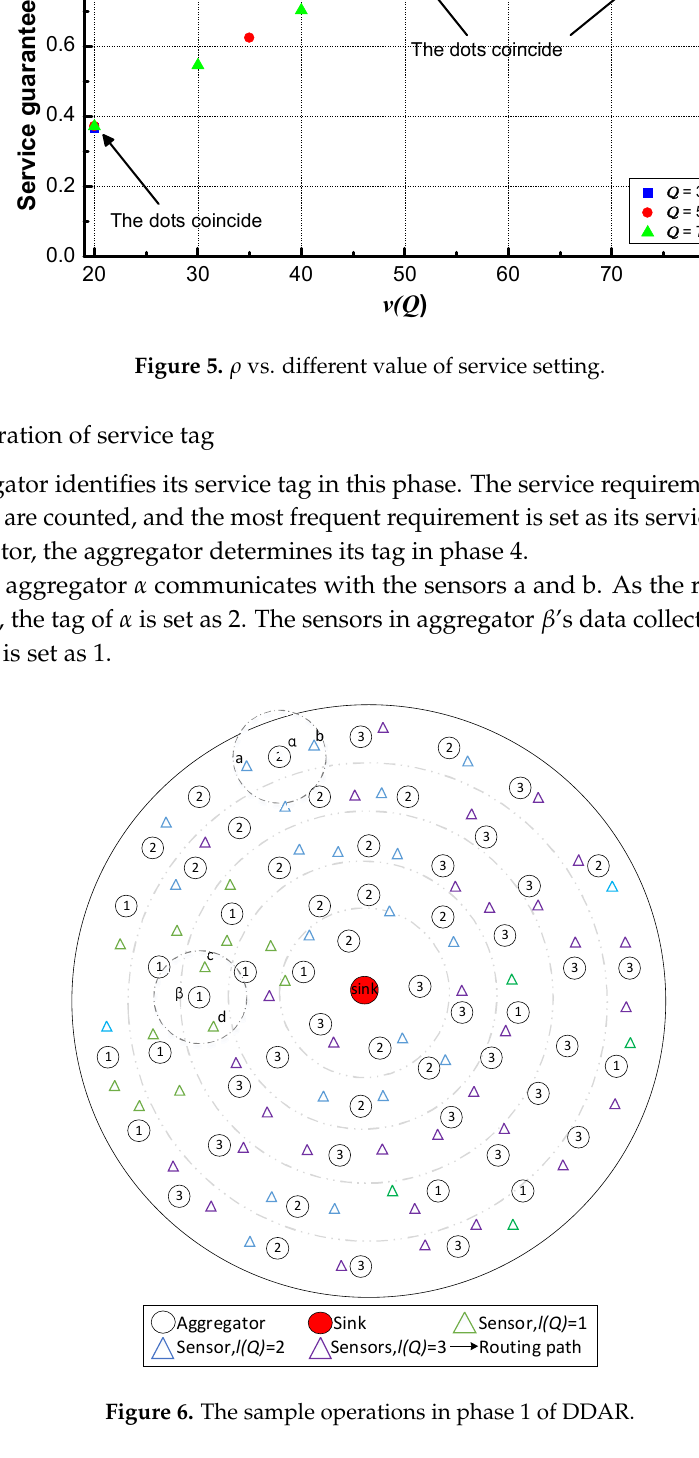
Algorithm 1: Configuration of Service Tag of Aggregator (cid:2252)